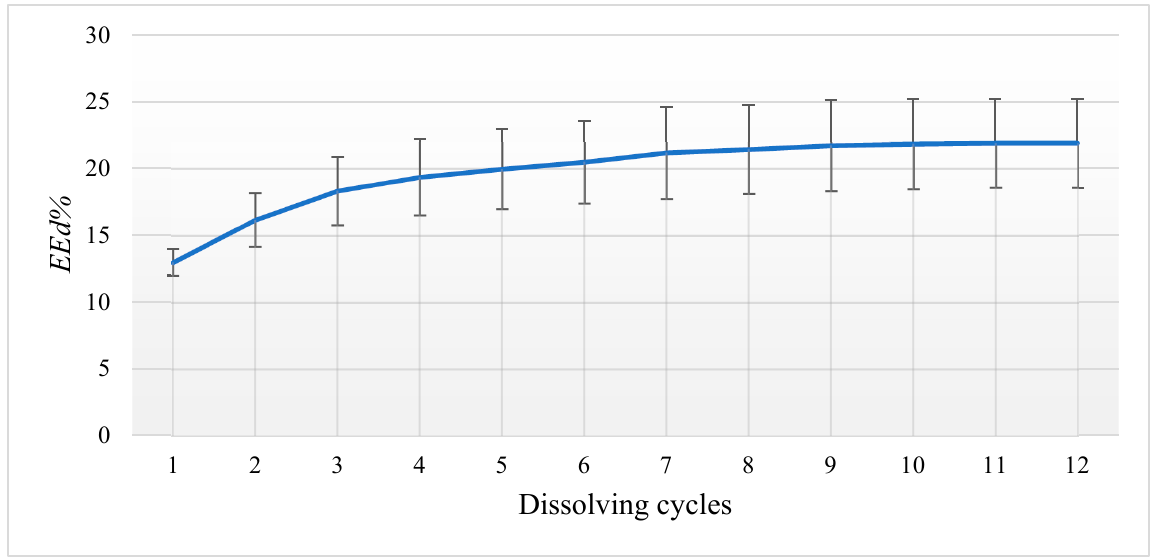
Figure 1. EGCG encapsulation e ffi ciency from repeated dissolving of EGCG-HNT in ethanol.